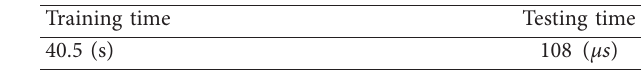
Table 10: Computational times of the proposed model of the 10mm